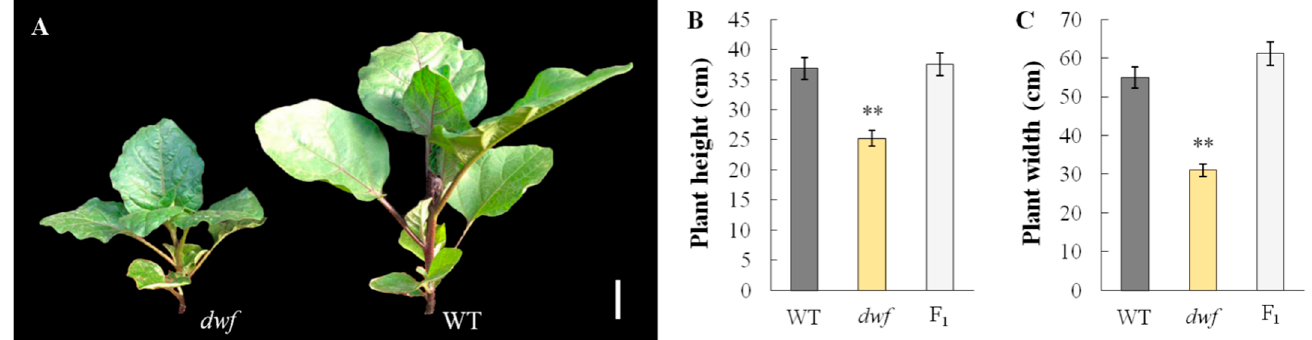
Figure 1. Comparisons of plant height and width of dwf, WT, and F 1 plants. ** Significantly different at p = 0.01 by the t test. ( A ) The plants of dwf and WT; ( B ) The plant height of the dwf , WT and F 1 ; ( C )The plant width of the dwf , WT and F 1 . Table 2. The segregation ratio of F 2. BSA-seq was used to identify the candidate gene for dwf . Two bulk DNA samples, dwarf bulk (M-bulk) and normal bulk (W-bulk), were constructed by mixing equal amounts of DNAs from 30 dwarf plants and 30 normal plants from the M 3 population, respectively. We obtained clean reads of 26.56 Gb (99.87% coverage) and 26.20 Gb (99.89% coverage) corresponding to the W-bulk and M-bulk, respectively; 97.71% and 96.74% of the reads from W-bulk and M-bulk were aligned to the reference genome (https://www.ncbi.nlm. were identified between the M-bulk and W-bulk. (cid:52) (SNP-index) > 0.5 was used as the